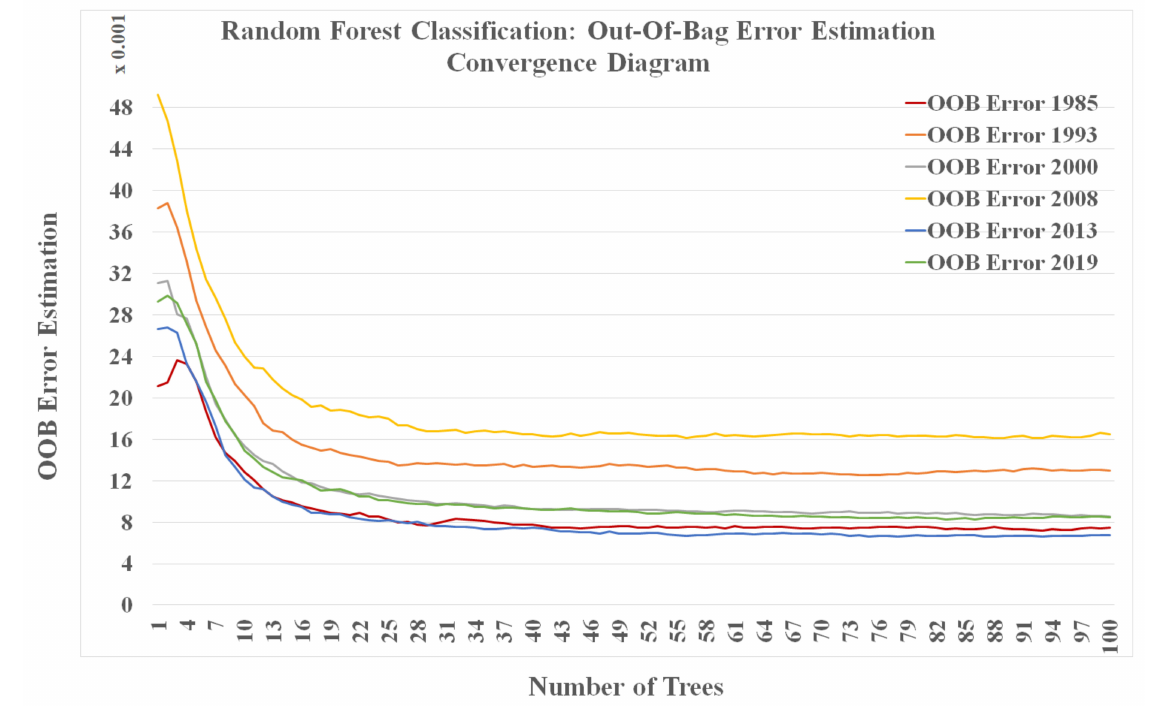
Figure 4. Effect of the number of trees of RF on classification